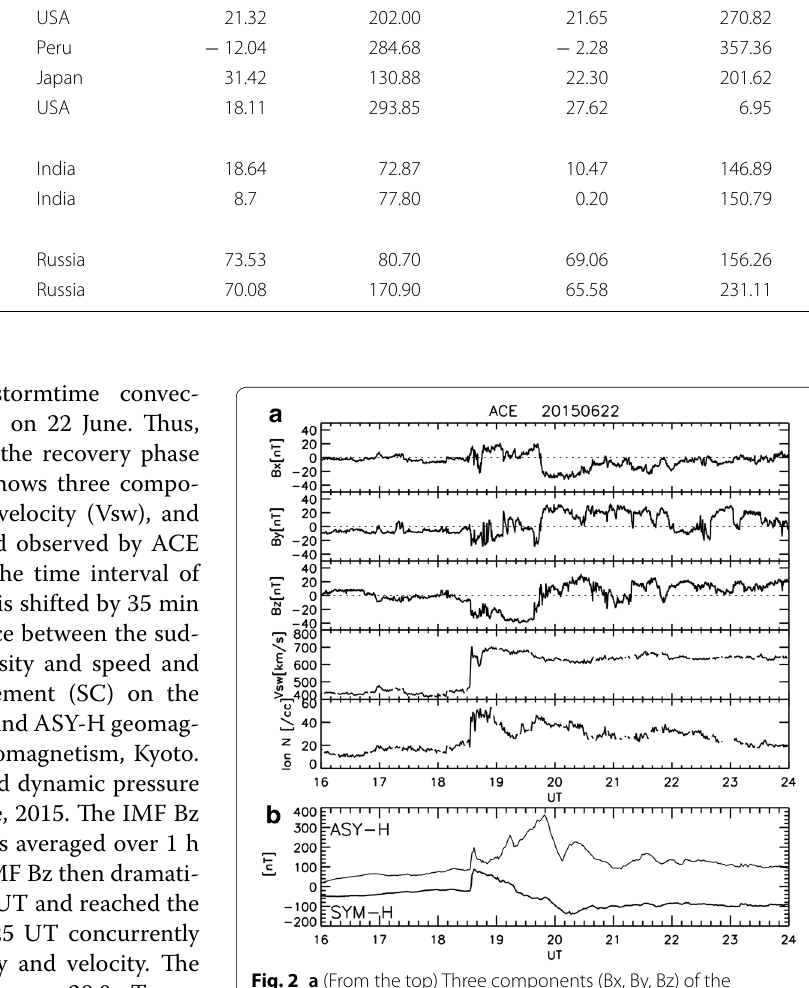
Fig. 2 a (From the top) Three components (Bx, By, Bz) of the interplanetary magnetic field (IMF), velocity (Vsw) and ion density (Ion N) of the solar wind observed by ACE at the Lagrangian point-1 (L1) during the geomagnetic storm on 22 June, 2015. The time of the ACE data is shifted by 35 min so that we can see the correspondence between the sudden increases in the solar wind density and speed and the geomagnetic sudden commencement on the ground (SC). b SYM-H and ASY-H geomagnetic indices from WDC C2